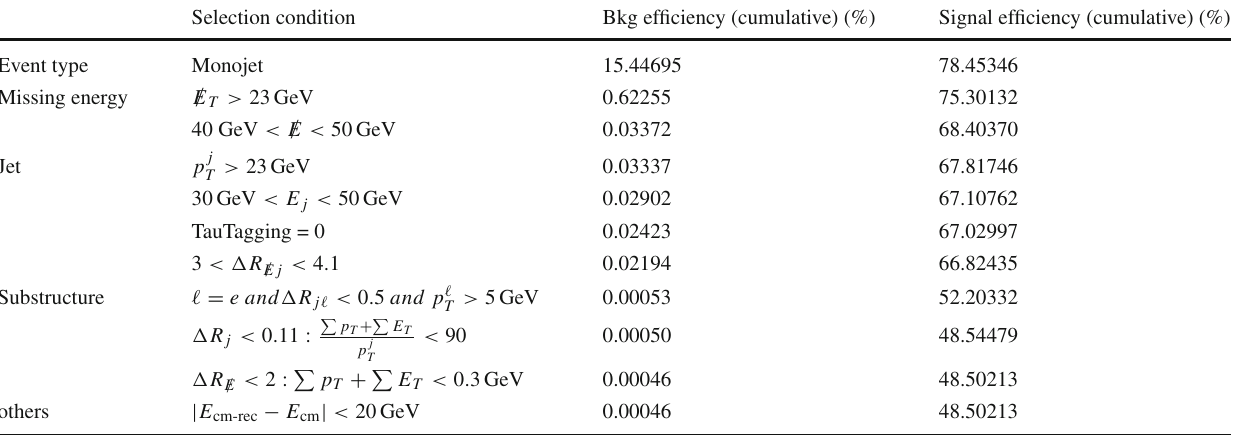
Table 1 The event selection conditions and their cumulative “bkg (sig- nal) efficiencies”, which means the percentage of the background (sig- nal) events surviving after a particular selection condition and the ones